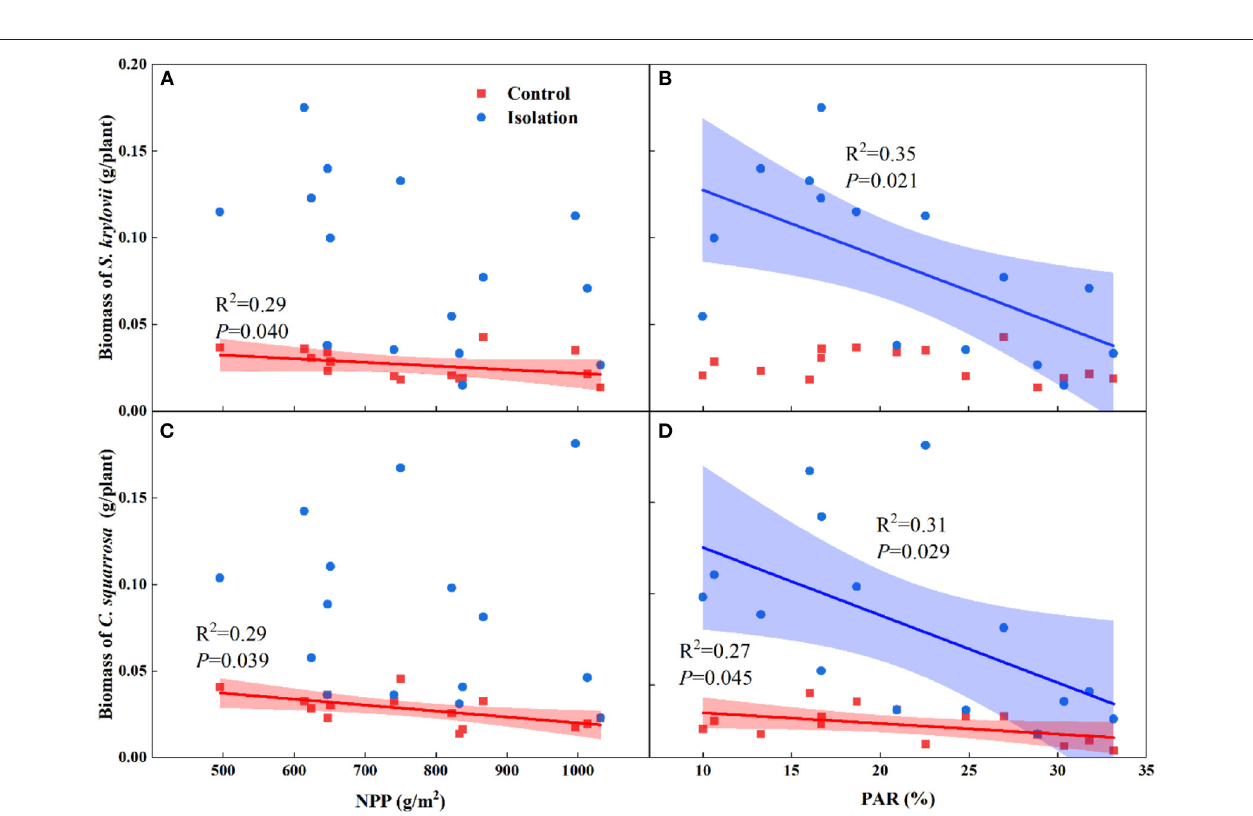
FIGURE 4 | Relationships of total biomass of S. krylovii (A,B) and C. squarrosa (C,D) with net primary productivity (NPP) and lower canopy intercept photosynthetic active radiation (PAR i ). Each data point represents mean biomass of each specie in each